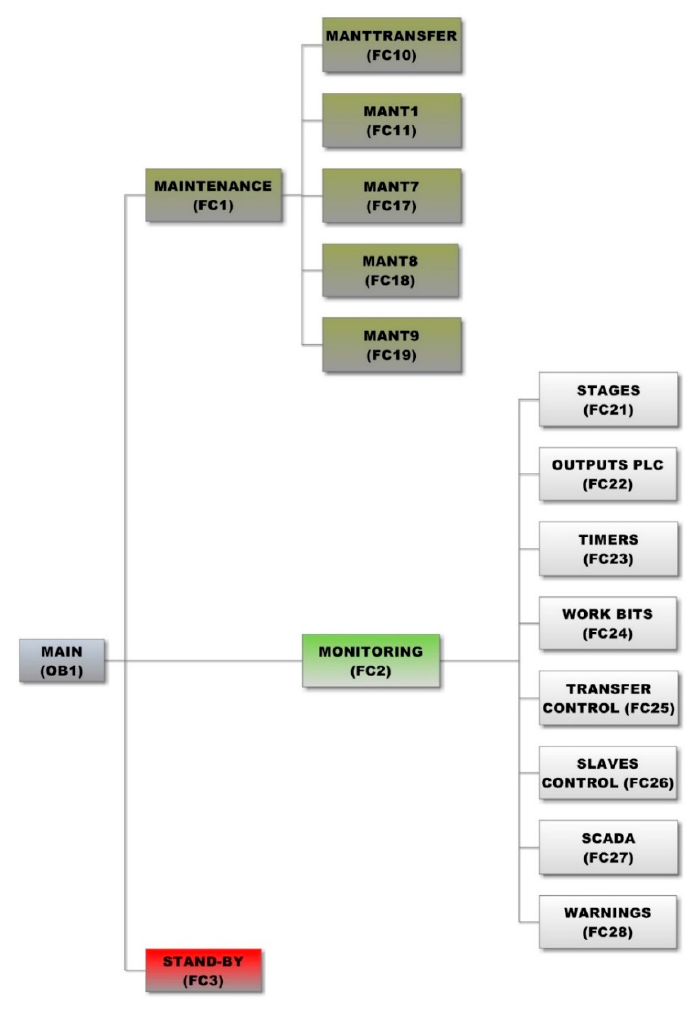
Figure 11. Block diagram of the master PLC program.